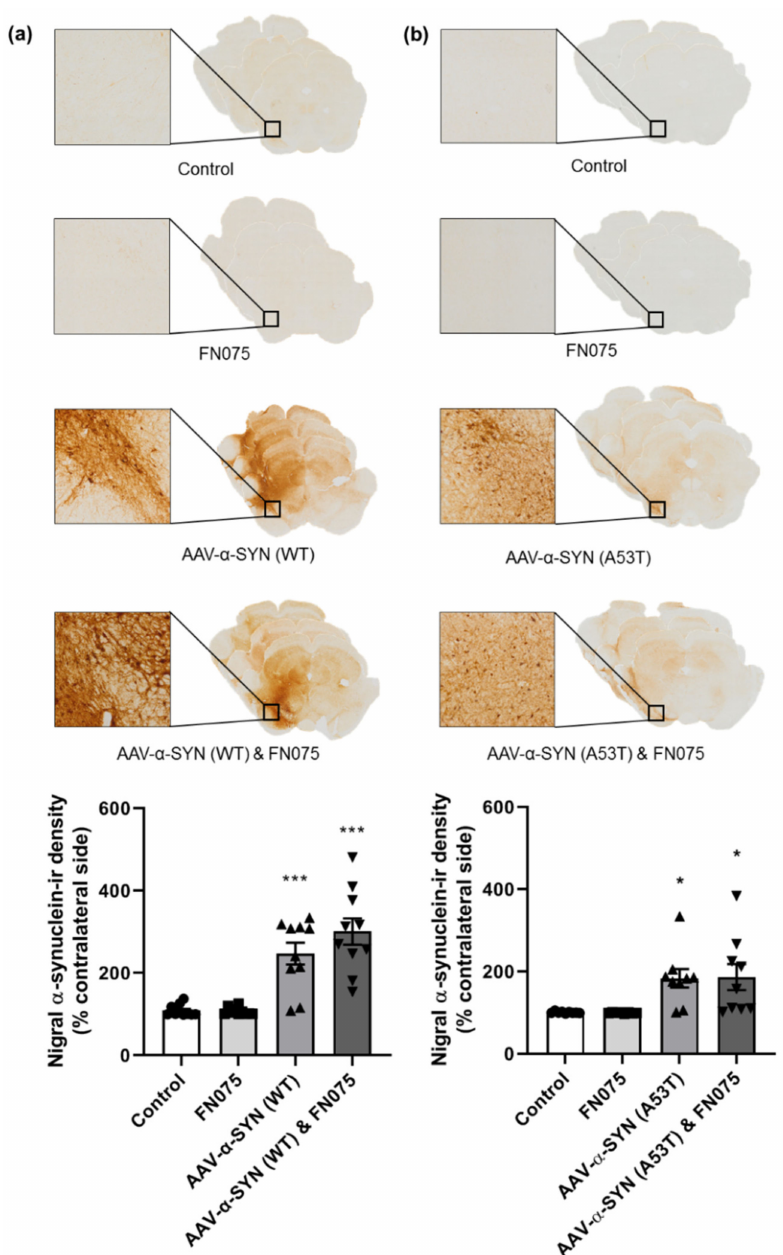
Figure 1. Immunohistological assessment of the impact of the AAV- α -synuclein vectors alone or in combination with FN075 on the expression of human α -synuclein in the substantia nigra. Both ( a ) AAV- α -SYN (WT) and ( b ) AAV- α -SYN (A53T), either alone or in combination with FN075, caused a significant overexpression of human α -synuclein in the substantia nigra. Data are represented as mean ± SEM with n = 8–10 animals per group. * p < 0.05, *** p < 0.001 vs. Control by one-way ANOVA with post hoc